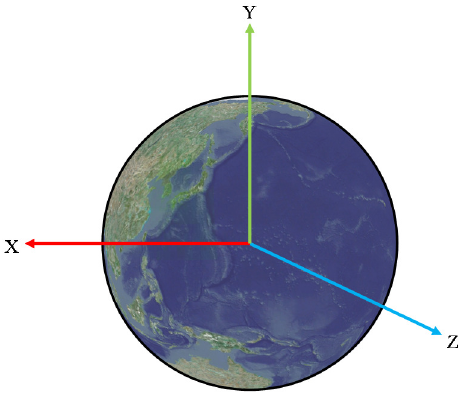
Figure 9. Sphere-based 3D coordinate system used in the proposed platform.